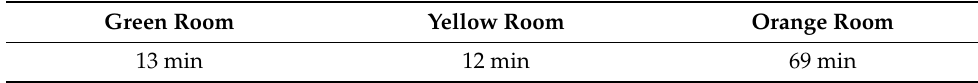
Table 2. Takt Time obtained from the hospital database.